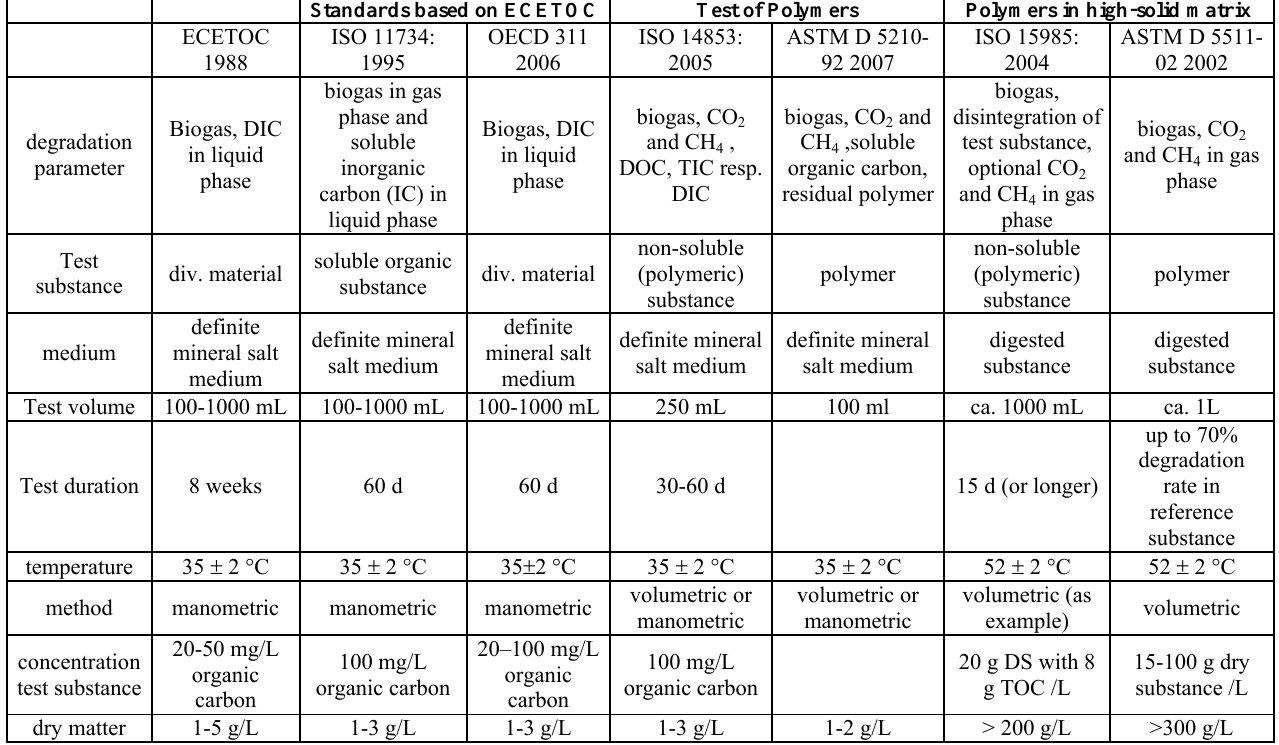
Table 3 . Standard screening tests for anaerobic biodegradation